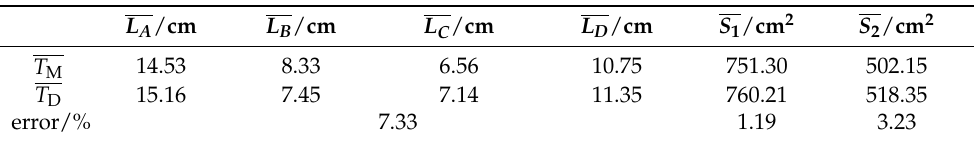
Table 2. Relative error of sample T1.